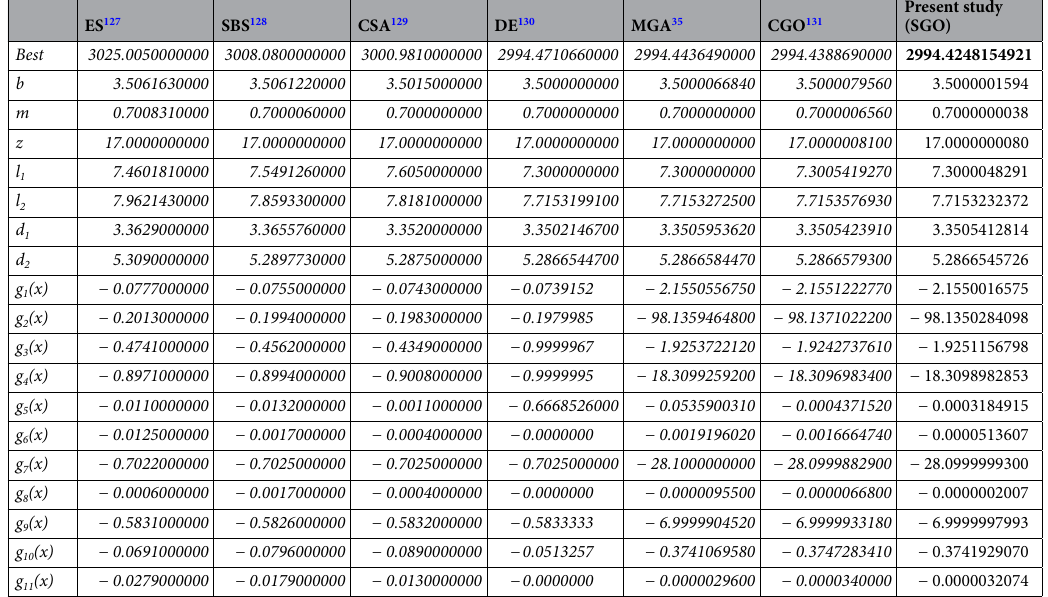
Table 10. Best outcomes of miscellaneous approaches for the speed reducer problem. Teeth module (m), face width (b), length of the first shaft between bearings (l1), the diameter of the first shaft (d1), number of teeth on pinion (z), length of the second shaft between bearings (l2), the diameter of the second shaft (d2). Significant values are in bold and italics.